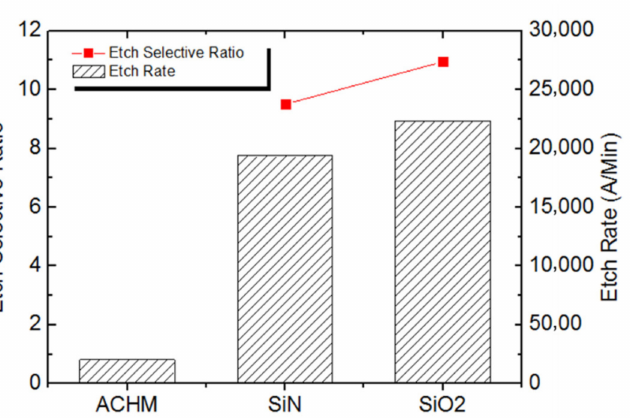
Figure 6. Etch Rate for ACHM, SiN and SiO 2 , and the etch selective ratio to SiN and SiO 2 at 400 ◦